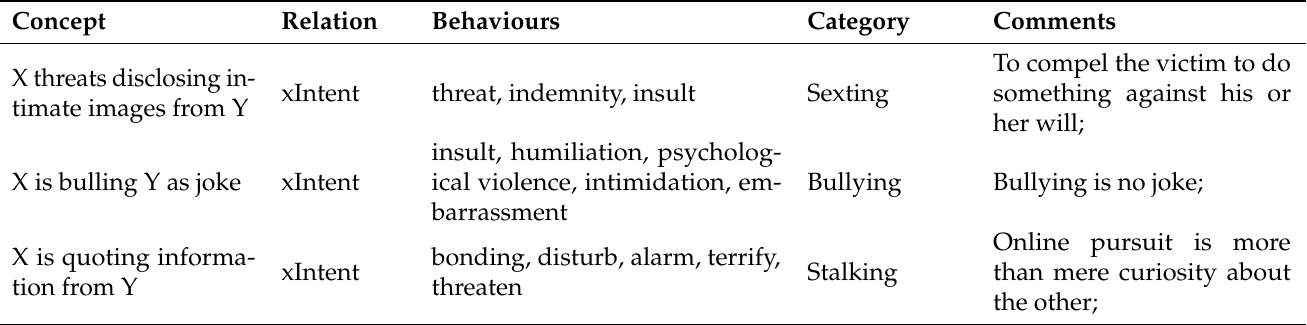
Table 4. Details of categories where offensive language might be